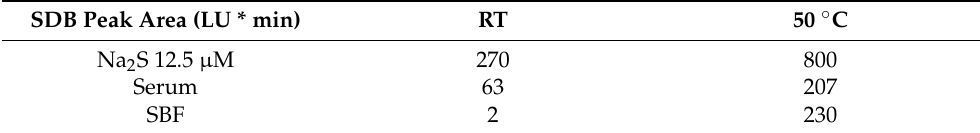
Table 1. SDB peak area of different samples at RT and 50 ◦